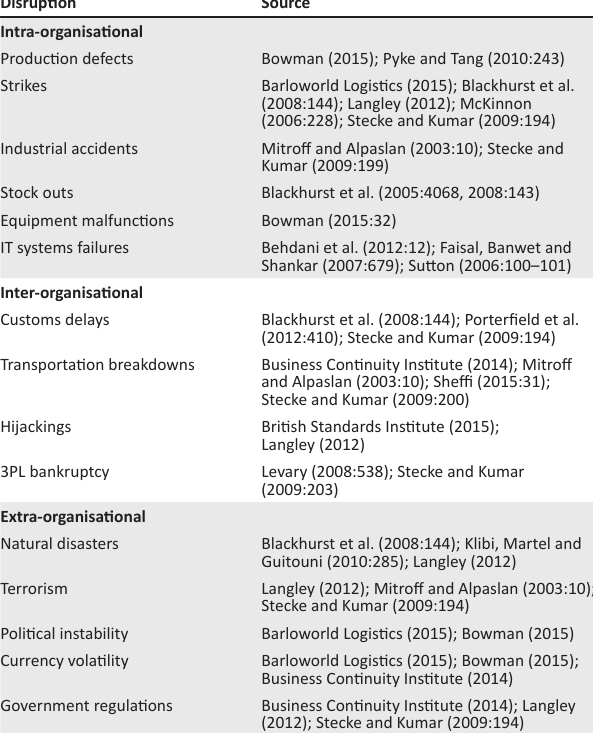
TABLE 2: Types of supply chain